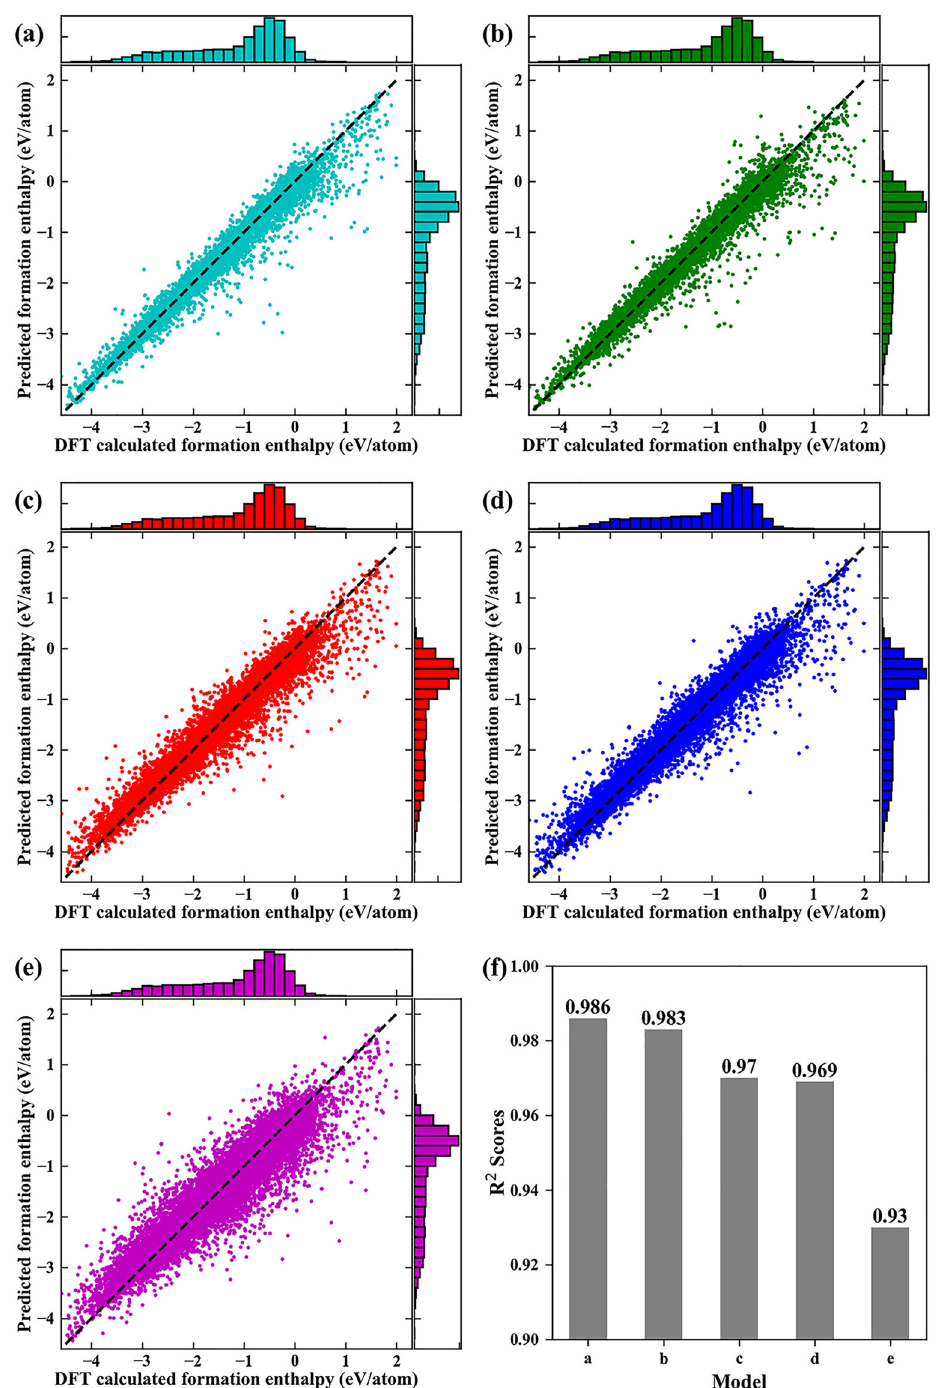
Fig. 1 Comparison of DFT-calculated formation enthalpy and predicted formation enthalpy (eV/atom) for different methods. a ASPH + Comp, b Voronoi tessellations, c ASPH, d Betti-0 ASPH, and e CM-sine. The top and right sub fi gure is the distribution of calculated data from ICSD and predicted data, respectively. f R 2 results for different models. All prediction data are the average performance obtained from tenfold cross-validations with 20